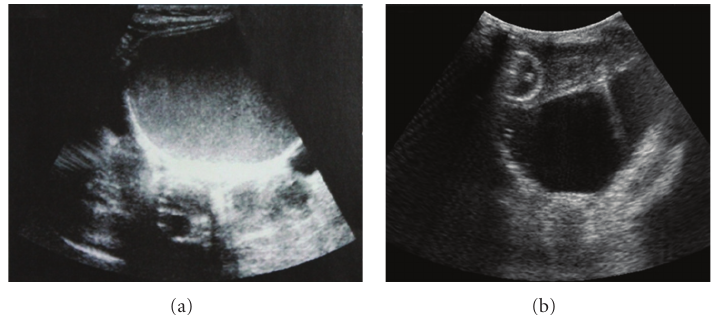
Figure 1: Pelvic US. (a) Transverse view shows a large well-defined cystic mass with internal echoes, which could easily be misinterpreted as overly distended urinary bladder. Note the bilateral ureteral dilatation. (b) Insertion of a Foley catheter makes it clear that the cystic mass is separate from the urinary bladder which is severely compressed and therefore hard to detect on ultrasound.